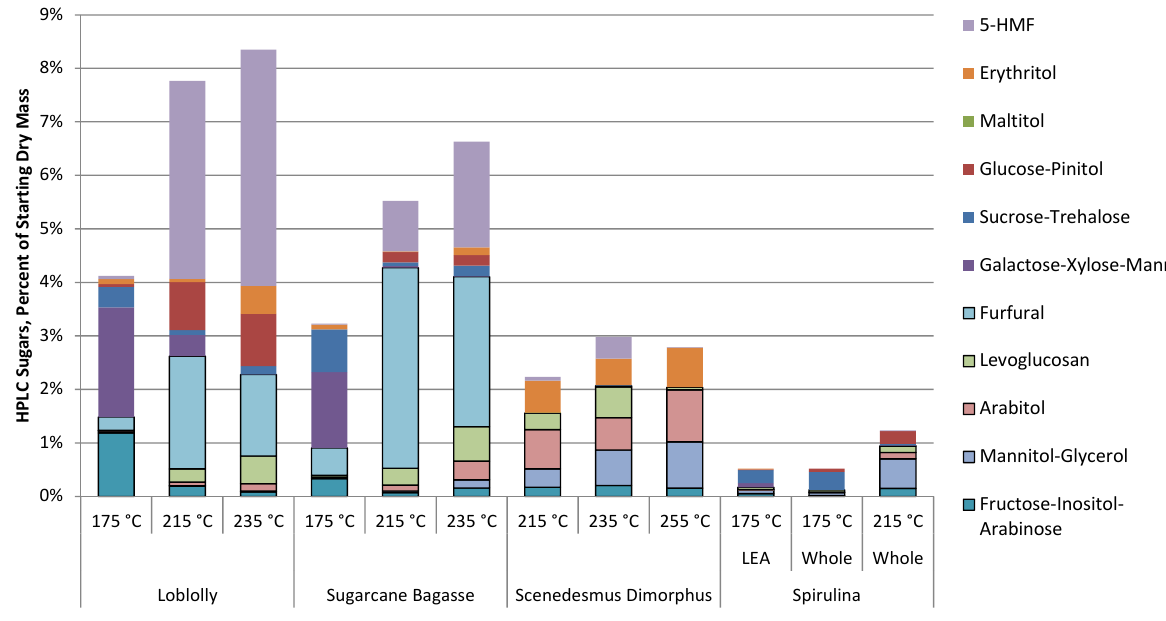
Figure 6. HPLC-RI analysis of sugars in aqueous products from HTC treatment of different feedstocks, expressed as percent of starting dry mass. Sugars noted as high value chemicals are highlighted by outlining. Loblolly and sugarcane bagasse results from